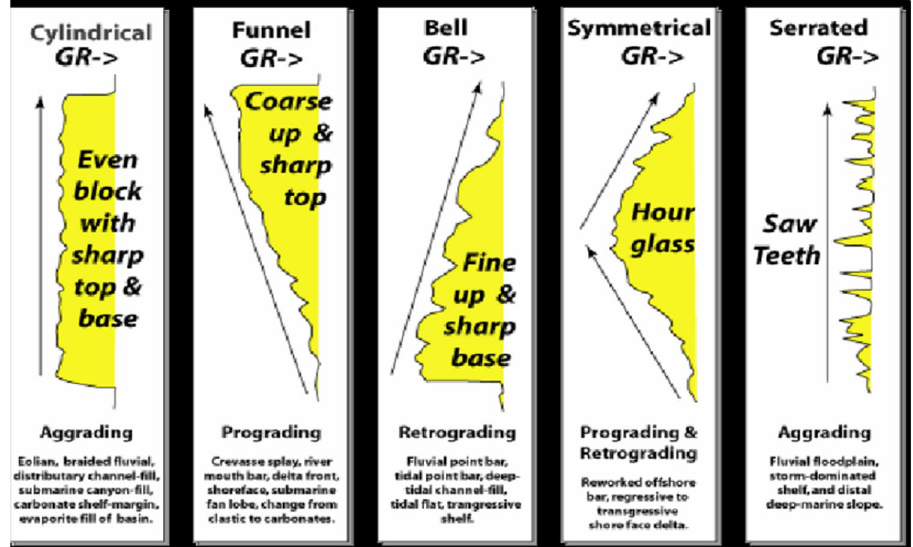
Fig. 6 Idealized gamma ray trends (modified by Reijers et al.